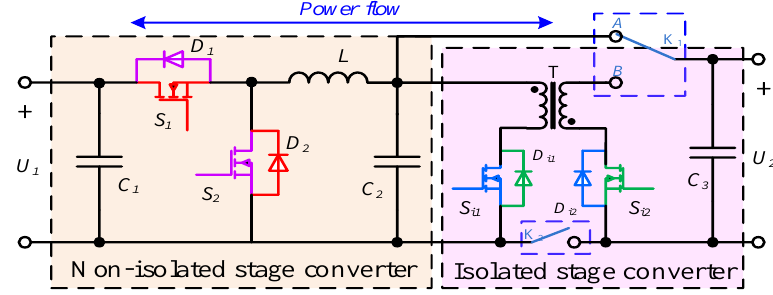
Figure 3. Proposed multifunctional bidirectional dual-mode converter.